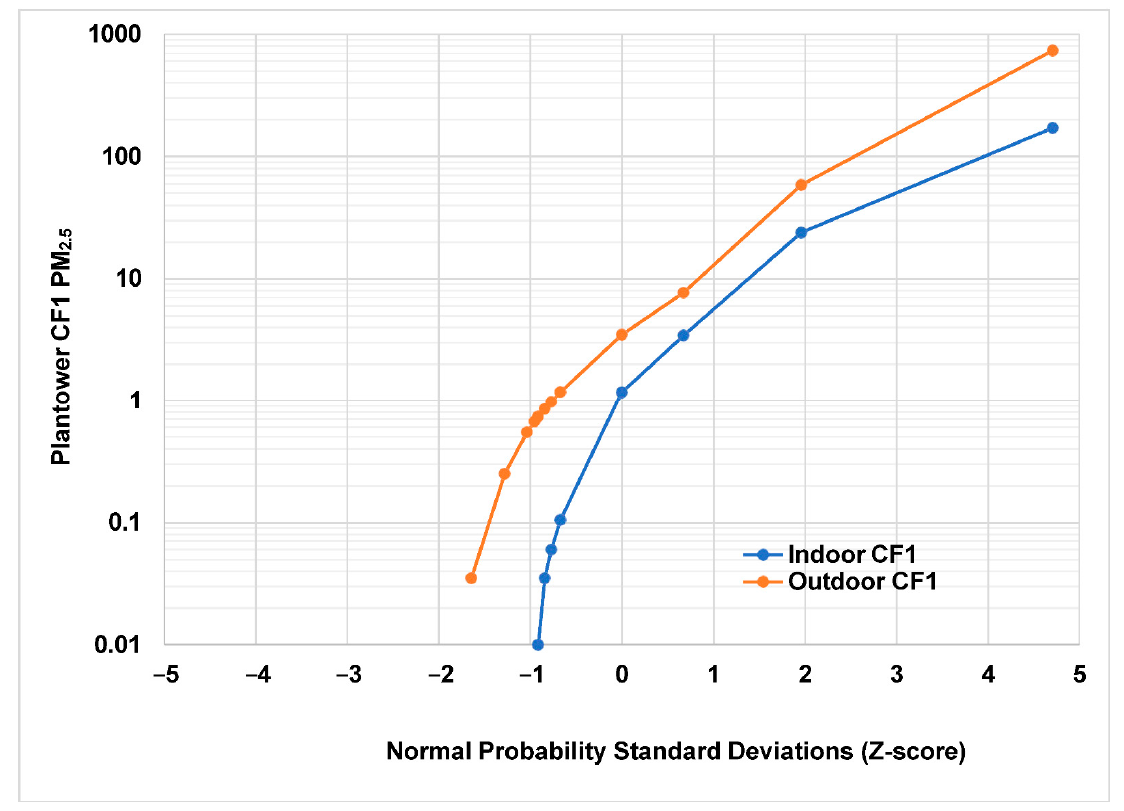
Figure 2. Same observations as in Figure 1 using the Plantower CF1 algorithm. Many measurements have been assigned a value of zero and cannot be shown on the logarithmic graph.